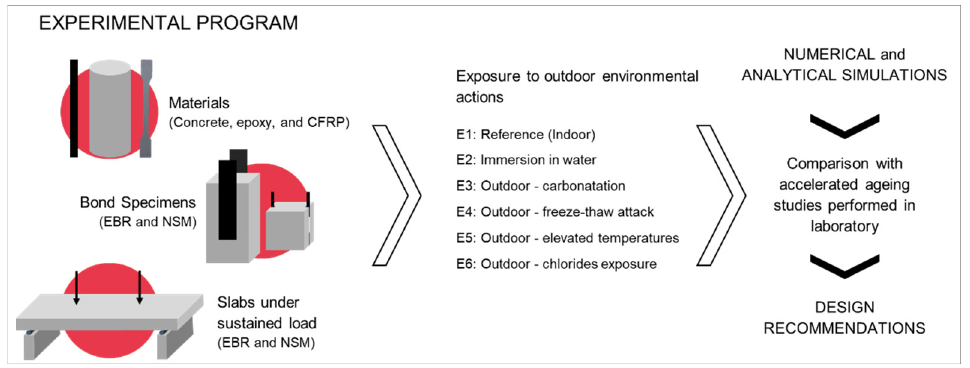
Figure 1. Flowchart of the FRPLongDur Project. Table 2. Environments considered in the present study.